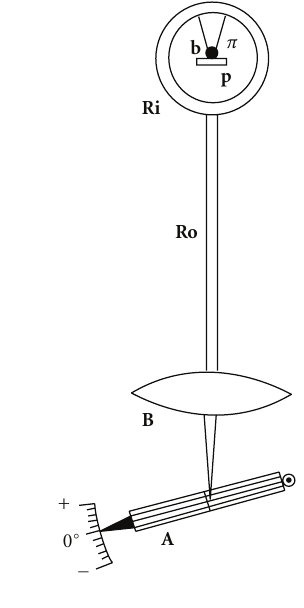
Figure 1: A schematic representation of the PP